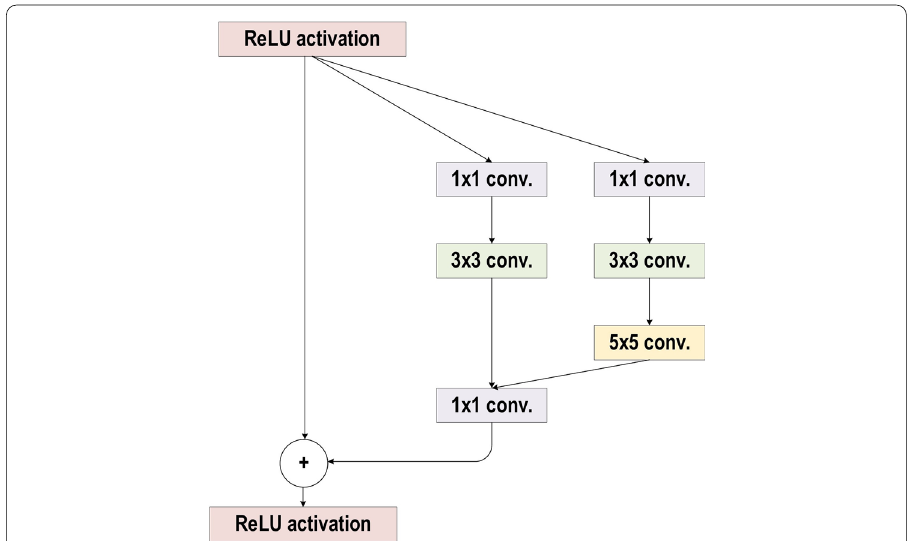
Fig. 21 The basic block diagram for Inception Residual